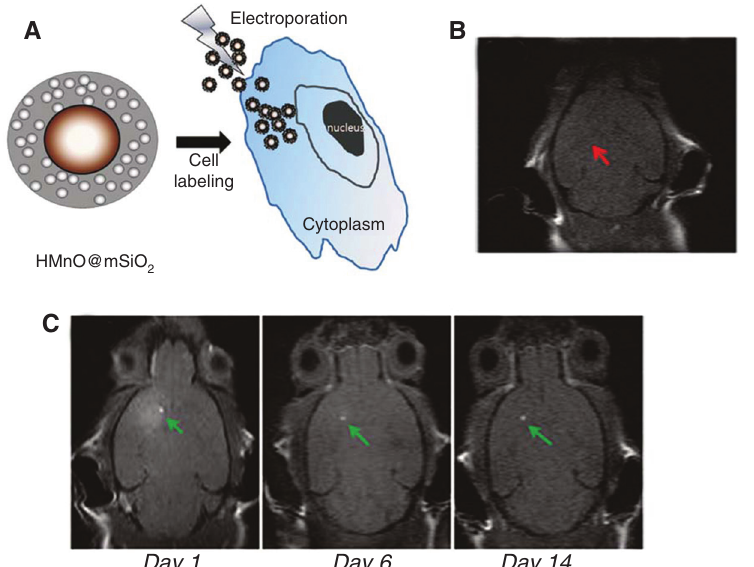
Figure 4 Magnetic nanoparticles as positive T1 contrast agents for labeling and MRI tracking of adipose-derived mesenchymal stem cells (MSC). (A) Labeling of MSC. (B) In vivo MRI of transplanted with unlabeled MSCs. (C) In vivo MRI of transplanted with HMnO@mSiO MSCs and were still visible 14 days after injection. (Reproduced with permission from Ref. [78], Copyright ACS Publications,